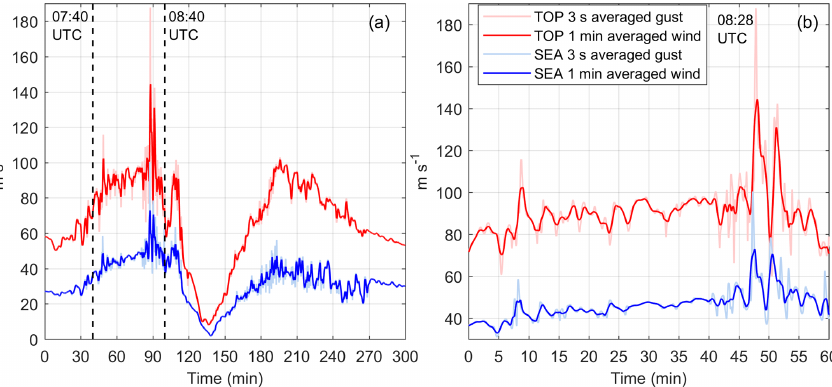
Figure 9. REAL030 time series in Saint Barthélemy: comparison between the upstream surface winds over the sea (SEA, Fig. 6) and the orographic surface winds over the mountain top (TOP, Fig. 8). (a) From 07:00 to 12:00UTC. (b) From 07:40 to 08:40UTC before landfall on Saint Barthélemy.